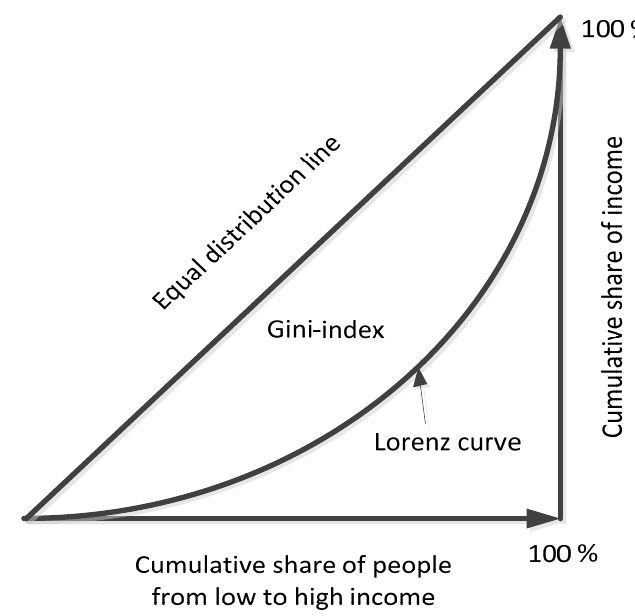
Figure 1. the Lorenz curve and the Gini coefficient. Source: Silber